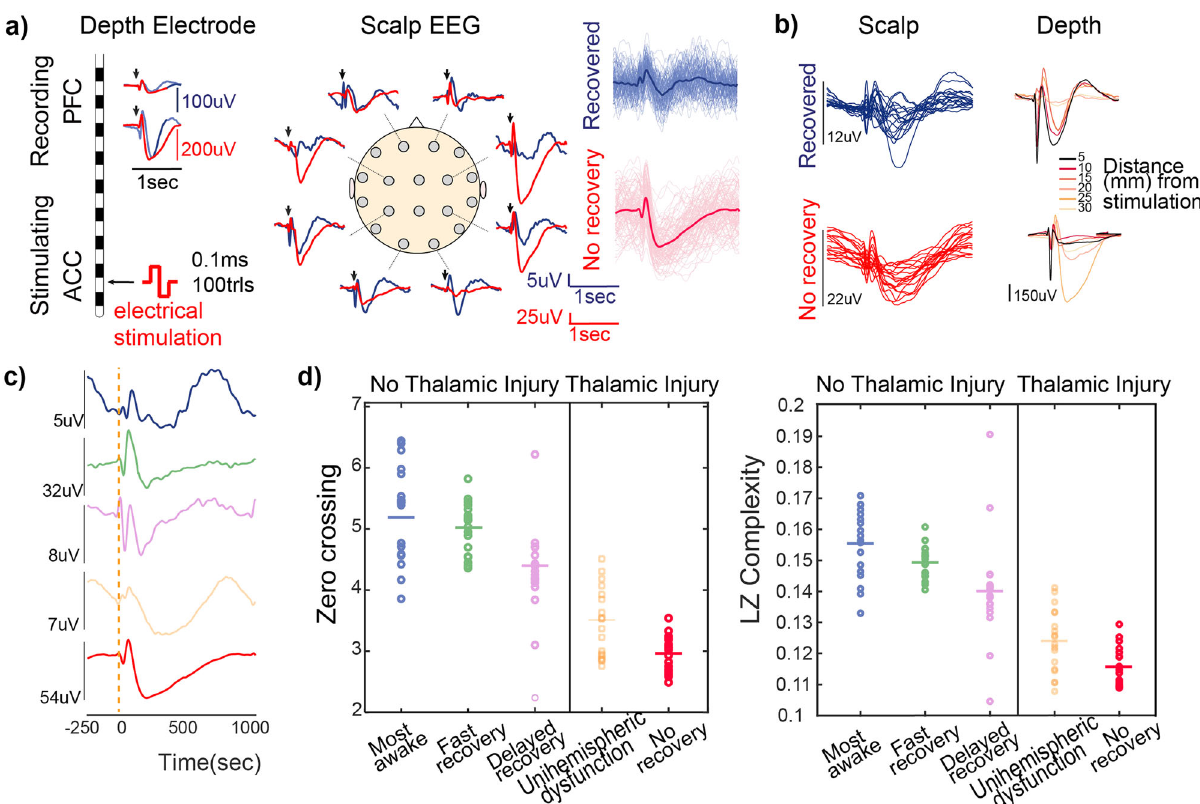
Fig. 2 Cortical evoked potentials exhibit distinctive features in patients with thalamic injury. a The evoked responses to ACC stimulation in a recovering comatose patient with no thalamic injury and a patient with a bilateral thalamic injury who never recovered consciousness are overlaid in blue and red, respectively. b Propagation of these evoked responses across scalp and depth channels are shown. c A representative scalp evoked response to ACC stimulation in each sTBI patient is shown. d Evoked responses across patients were classi fi ed based on their complexity using zero-crossing (left panel) and LZ complexity (right panel). Each circle represents the average of evoked recordings across trials (90 − 100 trials per patient) from each scalp contact. Horizontal lines represent the average across all scalp contacts. Evoked responses from patients with thalamic injury exhibited signi fi cantly diminished complexity with both measures ( n = 3564 trials recorded from 18 scalp contacts in patients with thalamic injury and 5220 trials for patients without thalamic injury, P < 0.001, two-tailed t-Test). In this fi gure, “ fast recovery ” and “ delayed recovery ” refer to Subjects 2 and 3, who followed commands at 38 and 51 days,